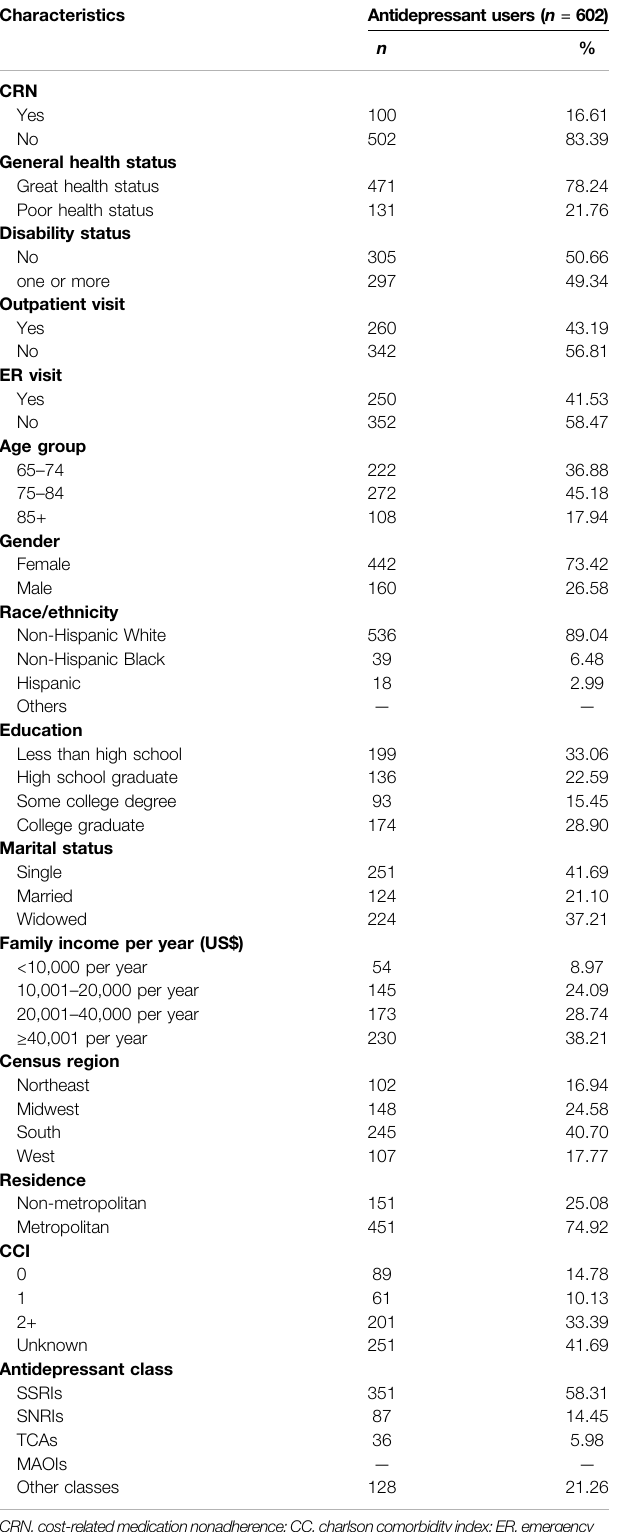
TABLE 1 | Baseline characteristic of the study